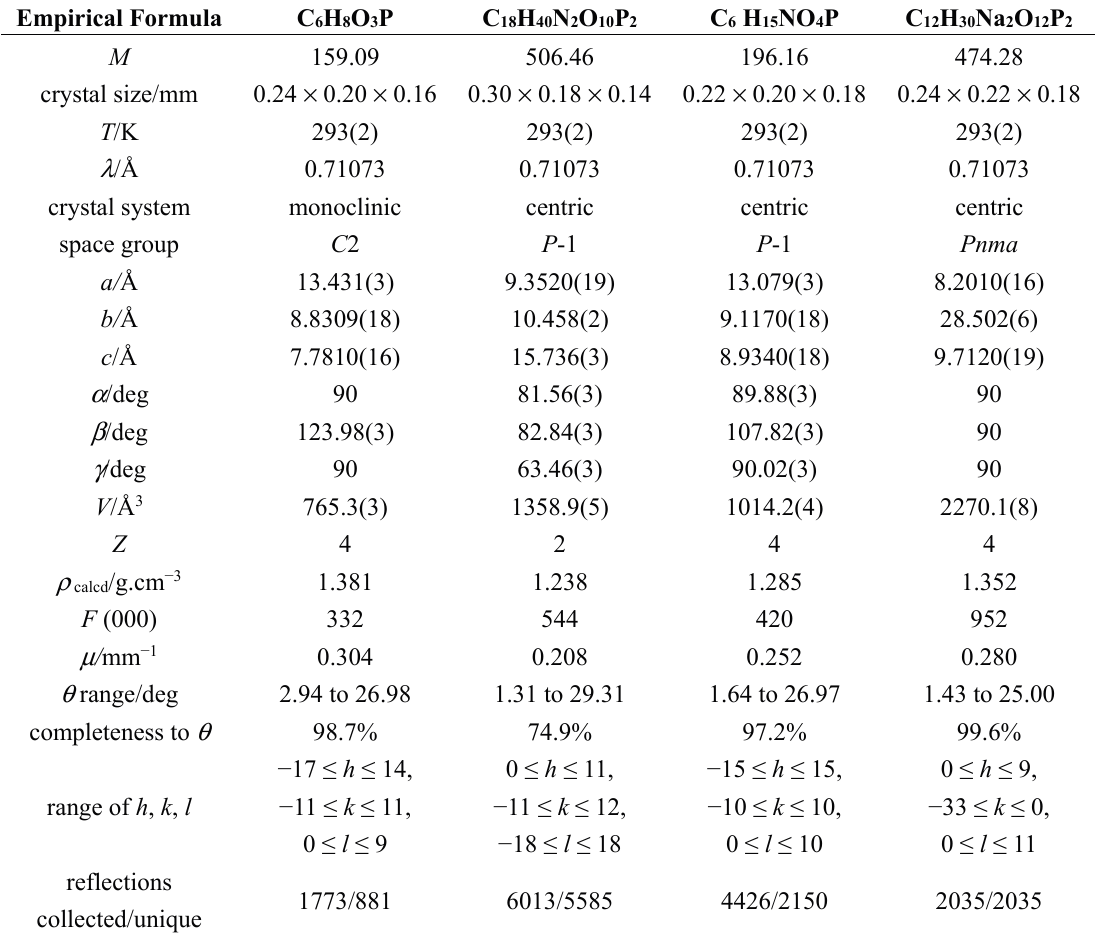
Table 2. Crystal Data and Structure Refinement Summary for Compounds 1 – 4